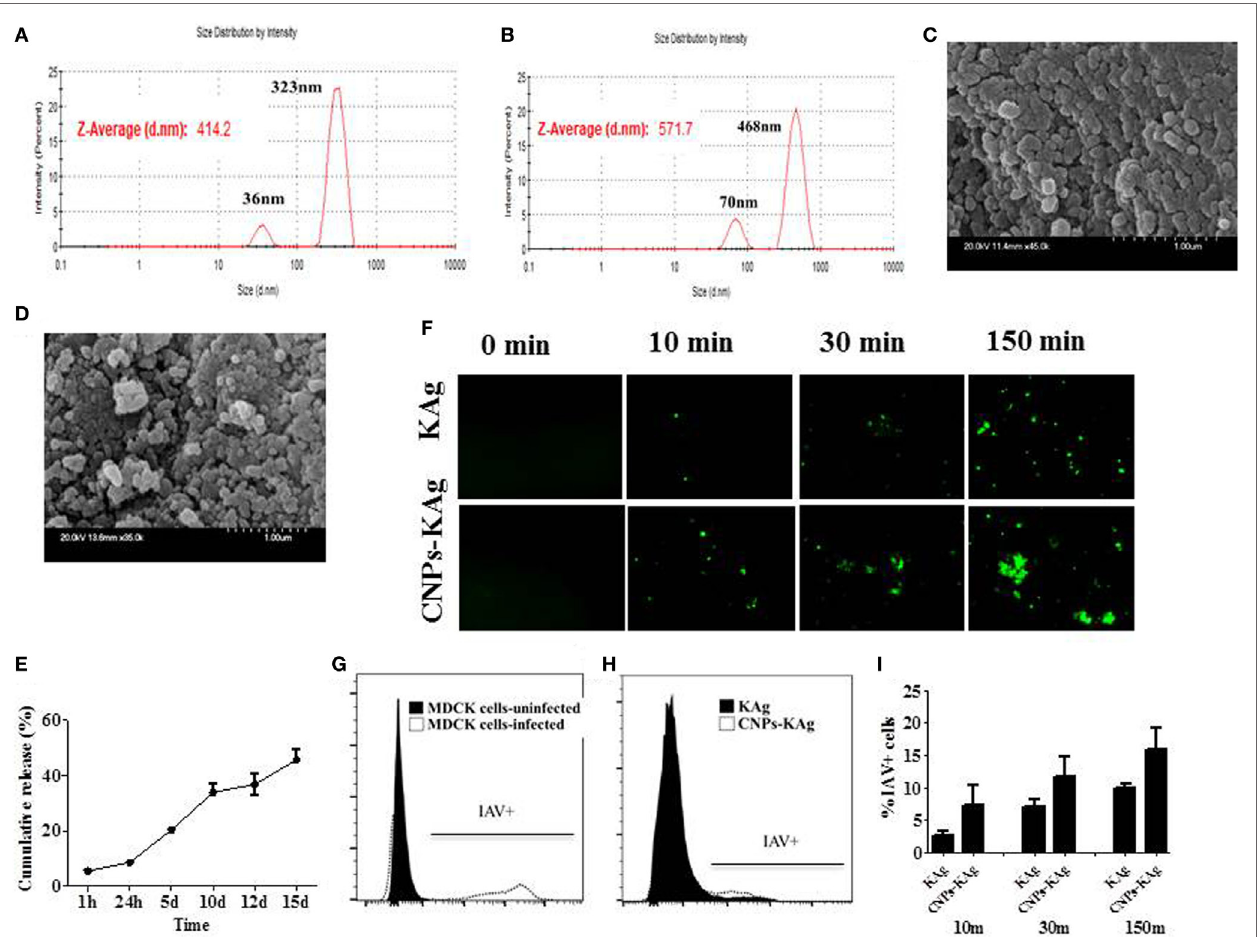
FigUre 1 | In vitro characteristics of chitosan nanoparticles (CNPs)-KAg. Diameter of (a) empty CNPs and (B) swine influenza A virus (SwIAV)-killed antigen (KAg)-loaded CNPs (CNPs-KAg) determined by dynamic light scattering. Scanning electron microscope (SEM) images of (c) empty CNPs and (D) CNPs-KAg. (e) Release of KAg from CNPs-KAg suspended in phosphate-buffered saline over a period of 15 days. (F) Uptake of soluble SwIAV KAg or CNPs-KAg formulation by monocytes/macrophages at indicated time points determined by fluorescent microscopy (Olympus, IX70, 20 × magnifications). The frequency of monocytes/ macrophages uptaken SwIAV KAg treated with soluble antigen or CNPs-KAg determined by flow cytometry: (g) SwIAV-infected Madin-Darby canine kidney (MDCK) cells as positive control; (h) a representative picture of SwIAV KAg or CNPs-KAg uptake by porcine monocytes/macrophages after 150 min treatment; and (i) percentage of cells with internalized SwIAV antigen at 10, 30, and 150 min